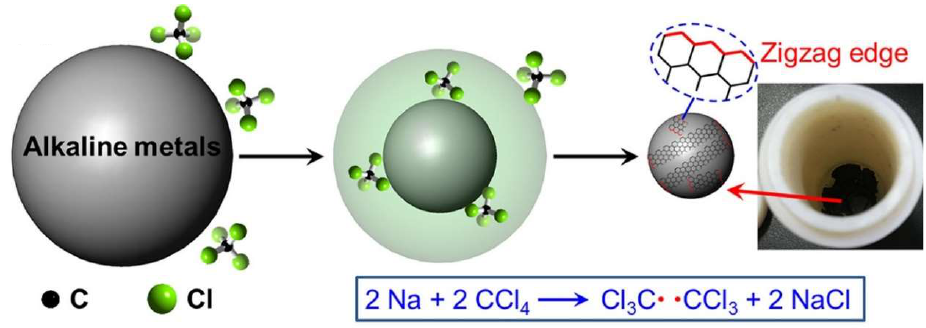
Figure 2. Synthesis of ferromagnetic carbon nanosheets. Reproduced from ref [11] with permission of Journal of Physical Chemistry C copyright 2020.